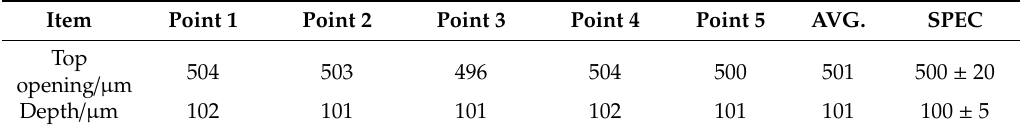
Table 5. The top opening and depth of the trench in E2 process.